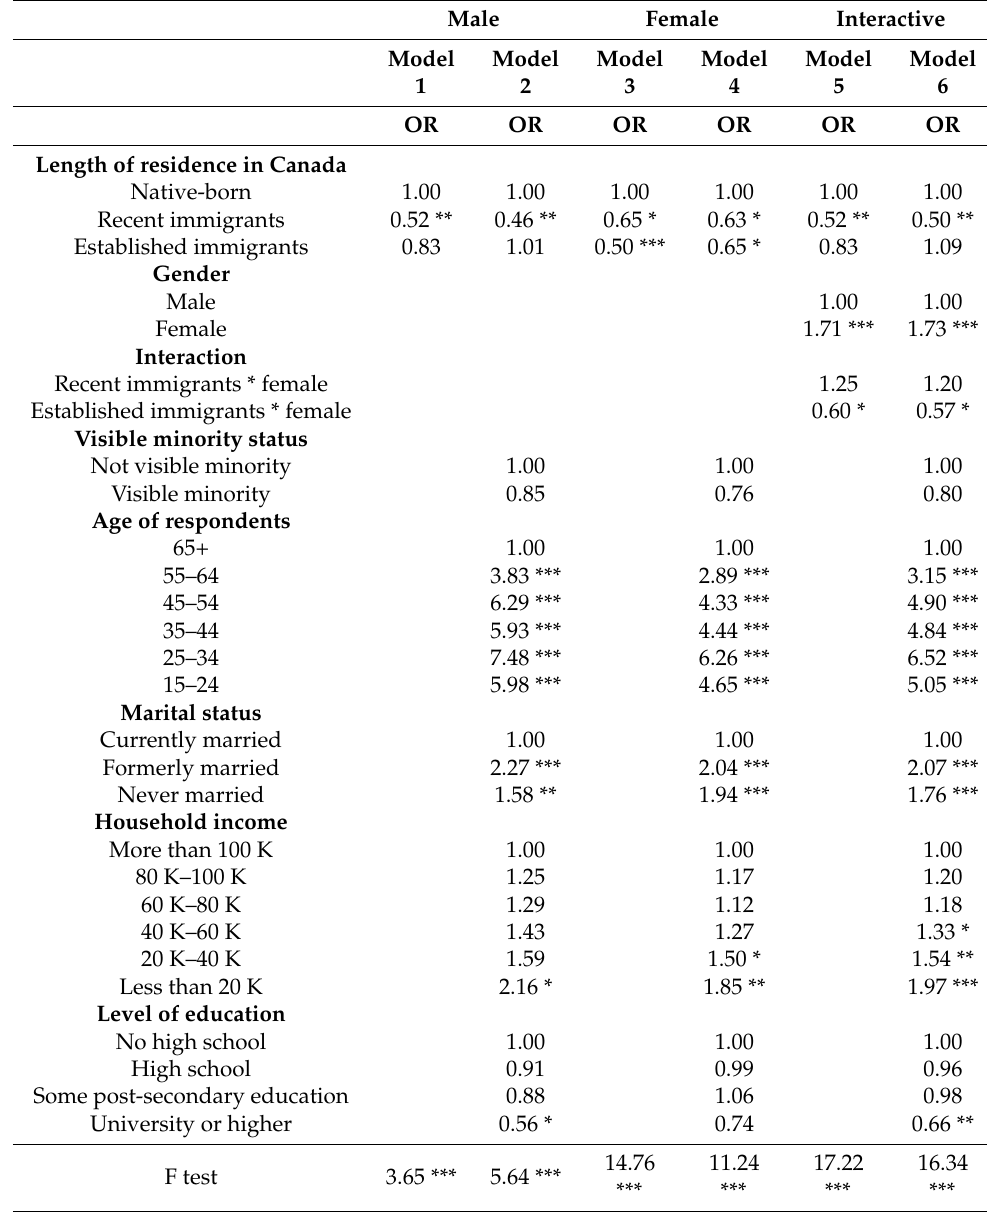
Table 2. Regression analysis of stalking victimization in the past five years among men and